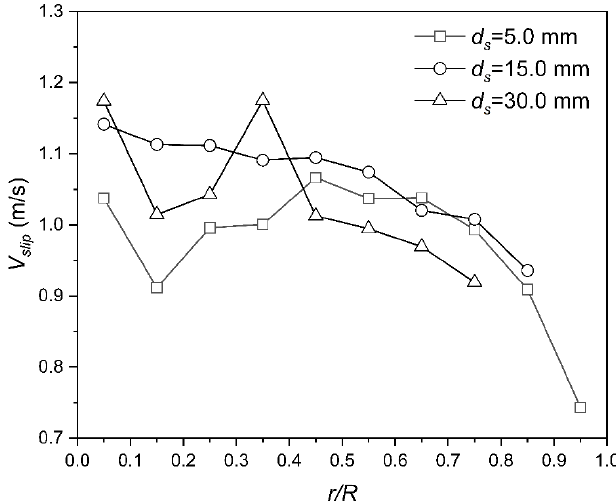
Figure 11. Effects of particle diameter on average slip velocity ( V mix ,0 = 4.0 m/s, C v ,0 = 5%).